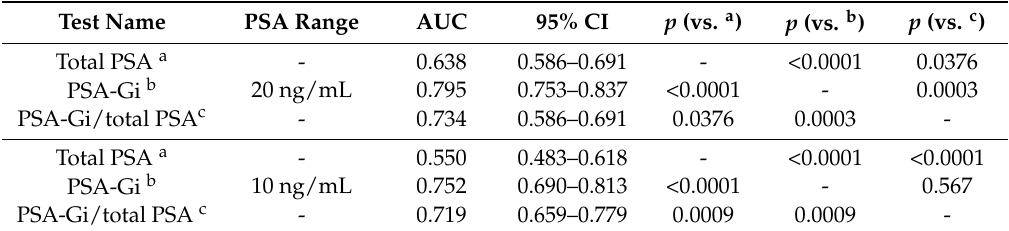
Table 2. Comparison of areas under the receiver-operator characteristic curve (AUCs) of PSA, PSA-Gi, and PSA-Gi/total PSA for the detection of